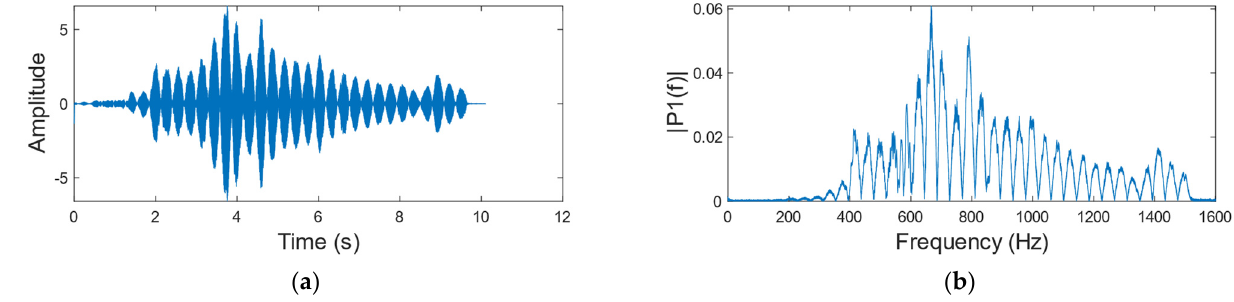
Figure 4. Reconstructed sinusoidal signal when a carton is the vibration object. ( a ) Time domain diagram. ( b ) Frequency domain diagram.